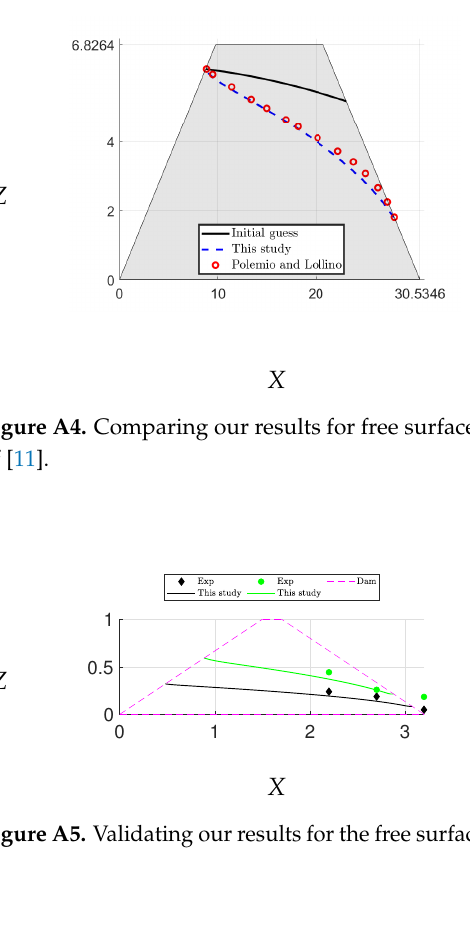
Figure A3. Position of the free surface from our calculations and from [8] showing the excellent agreement.